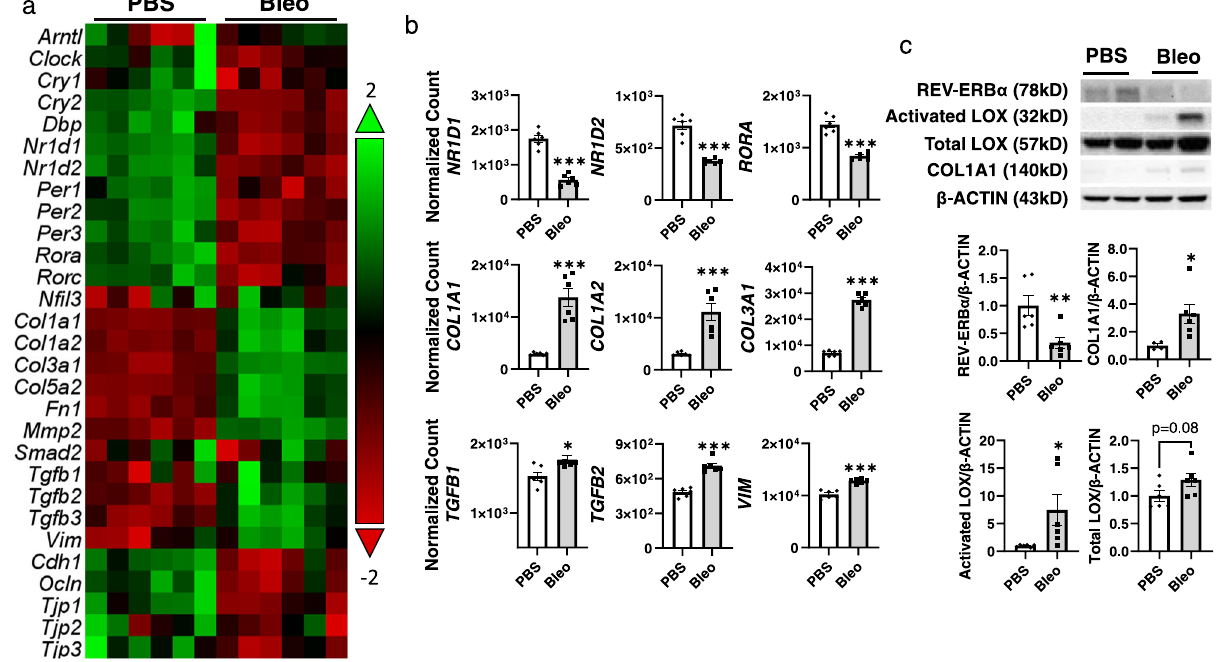
Fig. 2 | Altered circadian and pro fi brotic mRNA and protein expressions were observed in bleomycin induced fi brotic responses. Lungs from C57BL/6J WT mice (Combined male and female ( n =2 – 3 each) for analysis) dosed with bleo- mycin at day 14 were snap-frozen and used for RNA isolation. RNA isolated from lunghomogenateswereusedtoidentifythecircadianandpro fi broticrelatedgene expressions by our customized nanostring panel through nCounter SPRINT Pro- fi ler. The transcripts levels of RNA targets (Normalized Count) were normalized and visualized by nSolver software. a Dysregulated genes are shown as a heatmap